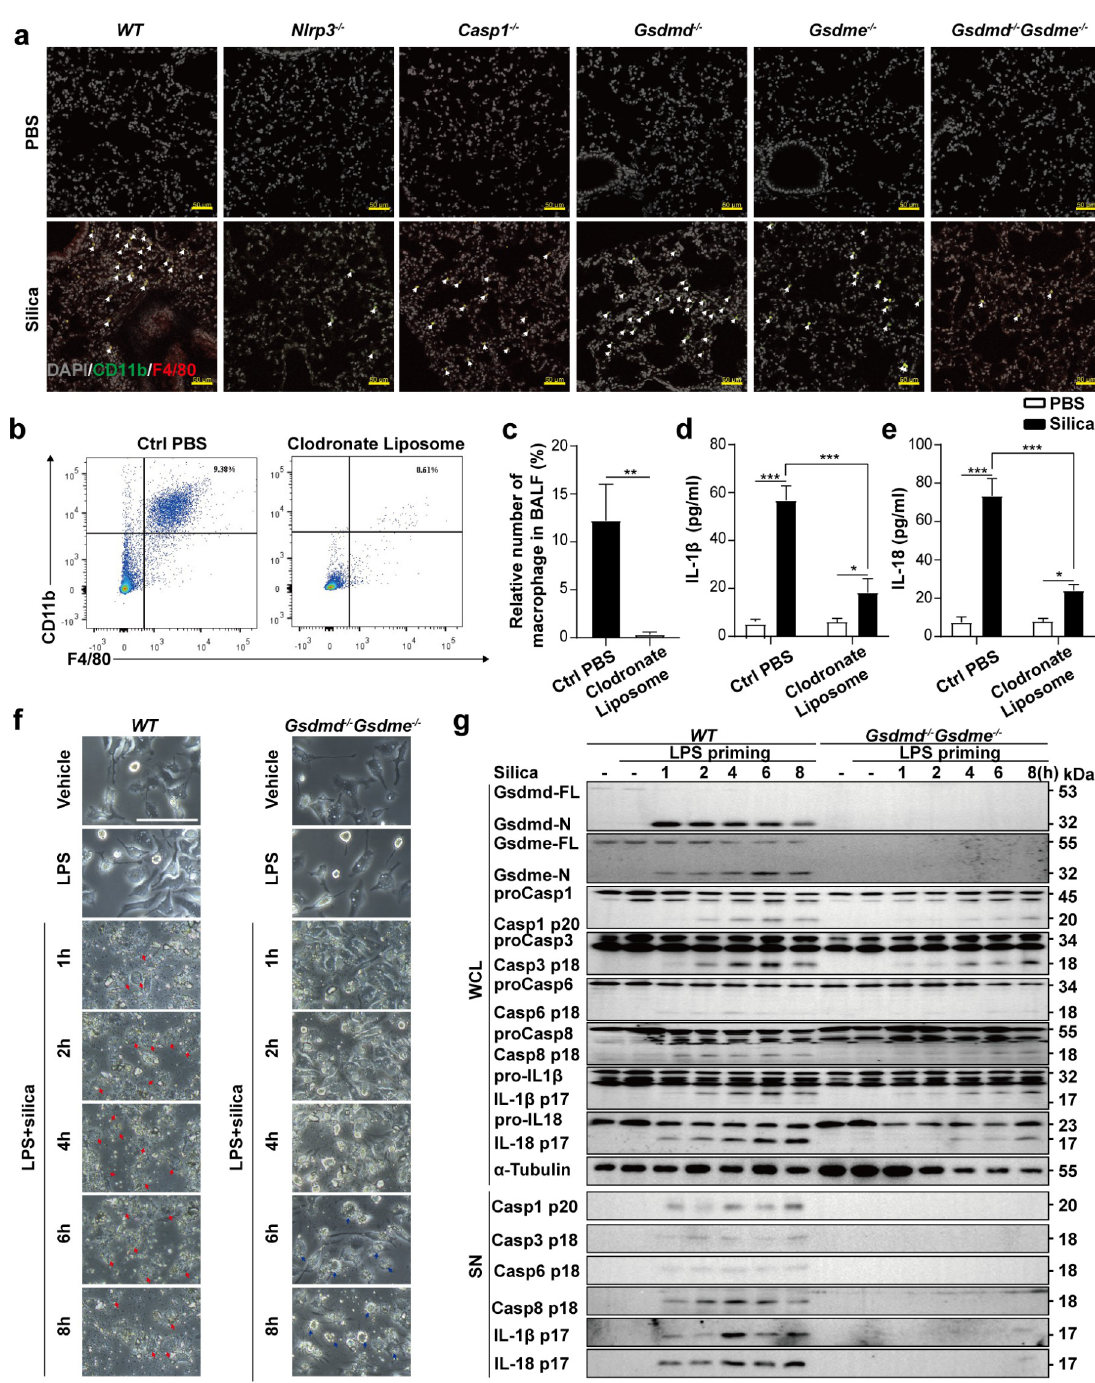
Fig 3. Deficiency of both Gsdme and Gsdmd impairs pyroptosis, proinflammatory cytokine release and immune cell infiltration. a Immunofluorescence images of recruiting macrophages in lung tissues 14 days after inhalation of PBS or silica, cells were labelled with antibodies against CD11b (green), F4/80 (red). DAPI (grey) localizes with the nuclei. Arrowheads indicate the infiltrated immune cells. The scale bar represents 50 μ m. b, c Relative number of alveolar macrophages in BALF of animals, n = 3. d, e IL-1 β ( d ) and IL-18 ( e ) in BALF of mice exposed to silica or PBS, n = 3. f Images of WT and Gsdmd -/- Gsdme -/- macrophages stimulated with silica for 1 h, 2 h, 4 h, 6 h and 8 h. Arrowheads (red) indicate pyroptotic cells, and blue ones indicate apoptotic cells. The scale bar represents 100 μ m. g Gsdmd, Gsdme, Caspase-1, Caspase-3, Caspase-6, Caspase-8, IL-1 β and IL-18 cleavage and secretion in both whole cell lysate (WCL) and supernatant (SN) in WT and Gsdmd -/- Gsdme -/- BMDMs treated with silica (0.25 mg/ml). Results are expressed as mean ± SD from three independent experiments. � P < 0.05, �� P < 0.01 and ��� P < 0.001.